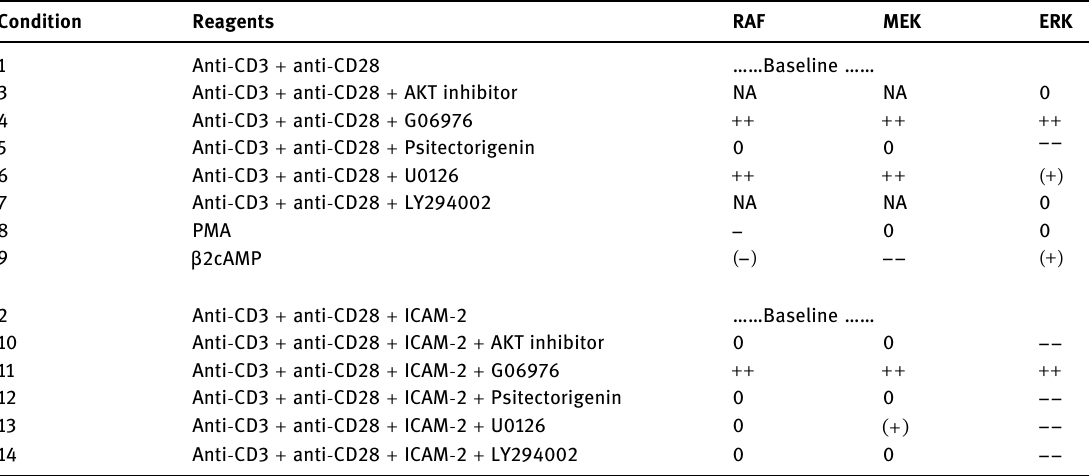
Table 2: Qualitative e ff ects of reagents on the measured abundances of active RAF, MEK, and ERK, as read o ff from the data in ref. [ 18 ]